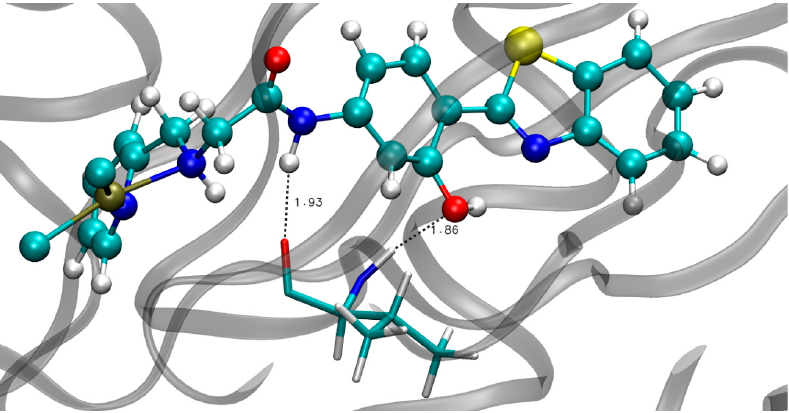
Figure 5. Two hydrogen bonds with higher frequency of occurrence between the PC and Val882 residue (1.93 Å and 1.86 Å) during the MD simulation.